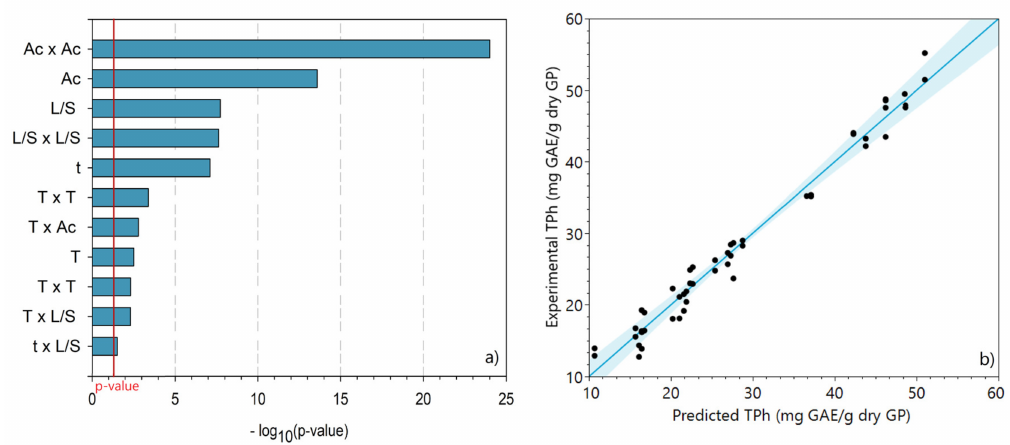
Figure 5. ( a ) Pareto plot of the statistically significant effects of the variables and their interactions for acetone extraction. ( b ) Comparison between experimental and predicted total phenolic content obtained from the central composite design of acetone extraction.